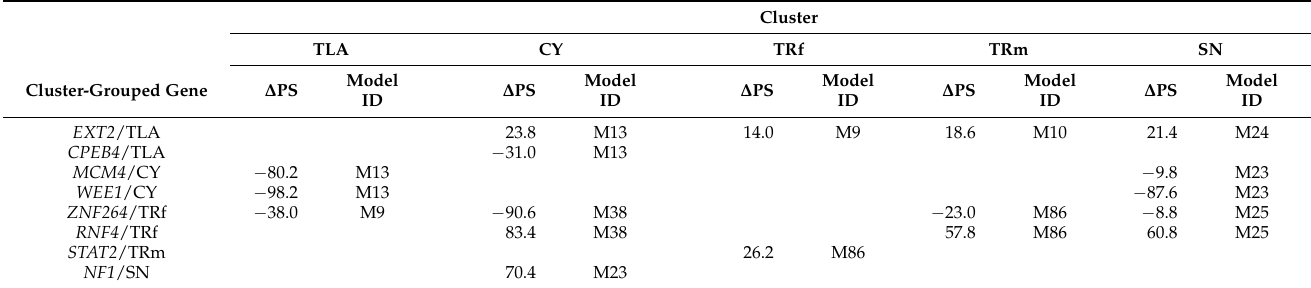
Table 4. Cluster–gene interactions summarized from two-cluster